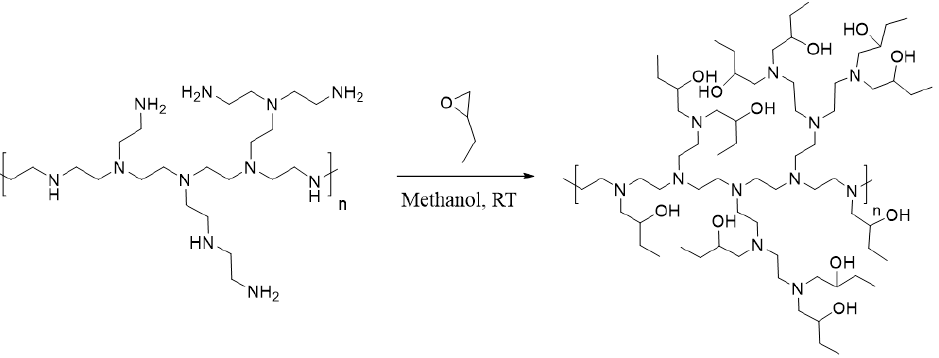
Figure 1. Synthesis of EB-PEI from reaction of commercial PEI and epoxybutane in methanol @ RT.